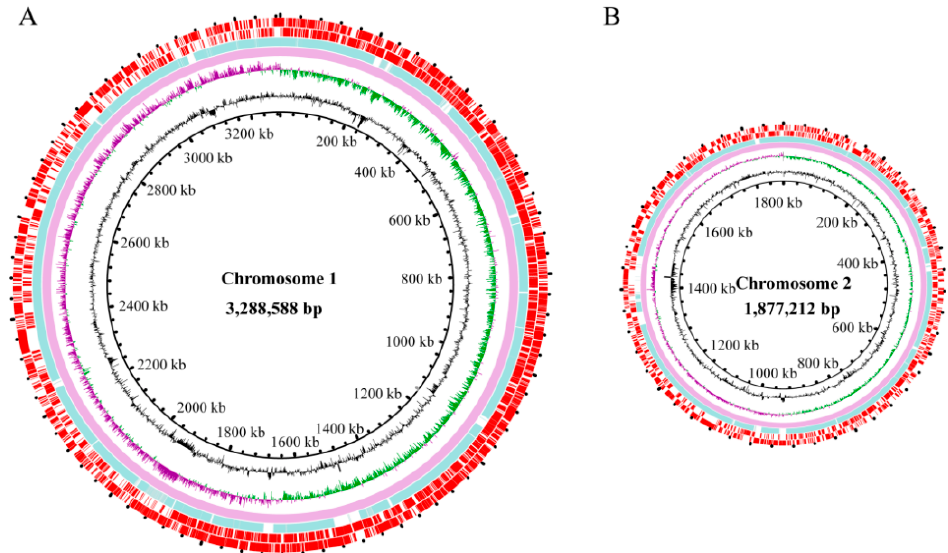
Figure 1. Genome circle maps of V. parahaemolyticus N10-18. ( A , B ) represent the larger and smaller chromosomes of V. parahaemolyticus N10-18, respectively. Circles from the inside to outside: GC contents (outward part means higher than average, inward part means lower than average); GC skew (purple value is greater than zero, green value is less than zero); the reference genome of V. parahaemolyticus RIMD2210633 (GenBank accession numbers: NC_004603.1 and NC_004605.1) and V. parahaemolyticus N10-18 genome (GenBank accession no. JALGSE000000000), respectively; and CDSs on the positive and negative chains, respectively.